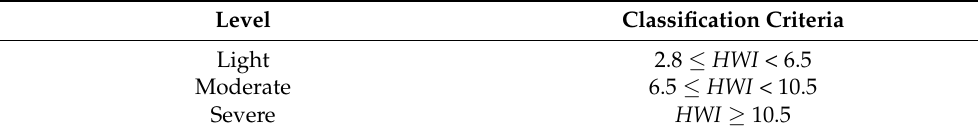
Table 2. Ranges used for HW level